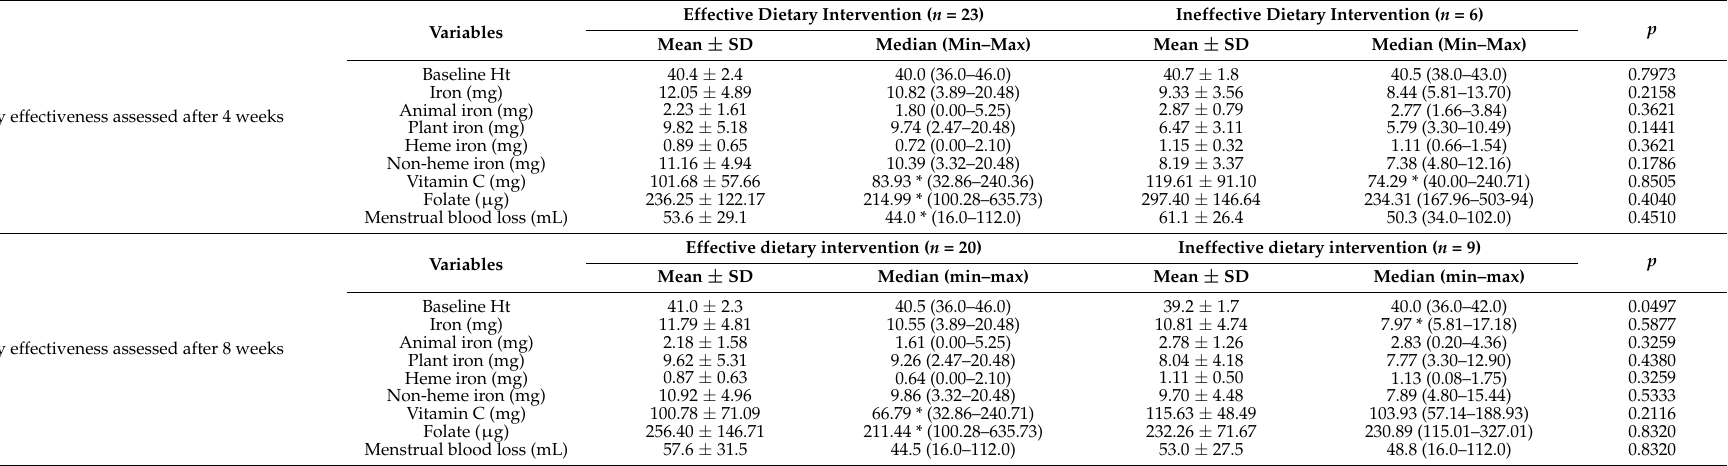
Table 6. The comparison of the baseline characteristics of the subsamples (hematocrit level, dietary intake, and menstrual blood loss) in subsamples stratified by the effectiveness of dietary intervention assessed for hematocrit level after 4 and 8